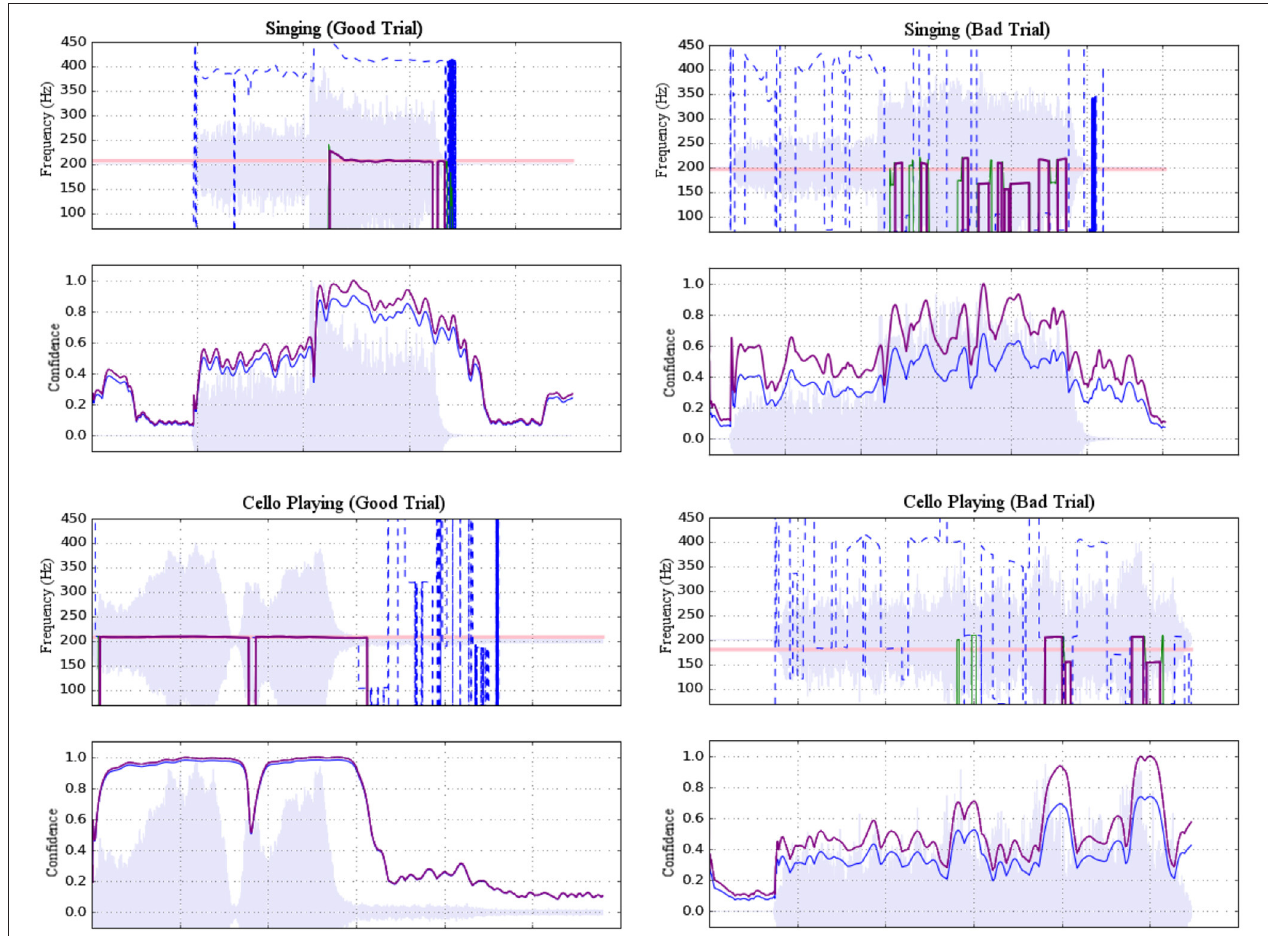
FIGURE 3 | Examples of accepted (left) and rejected (right) trials for both singing (top) and cello playing (bottom) . Each example shows a plot of pitch estimations above a plot of confidence ratings. For the former, dashed blue lines represent raw pitch estimation whereas solid purple lines represent potentially stable pitch estimates adjusted to the fundamental. For the latter, raw confidence ratings are shown in blue and normalized confidence ratings are shown in purple. Shading indicates amplitude